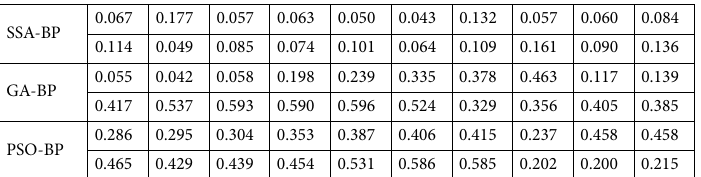
Table 10. Predicted value variance of SSA-BP, GA-BP and PSO-BP at P1.